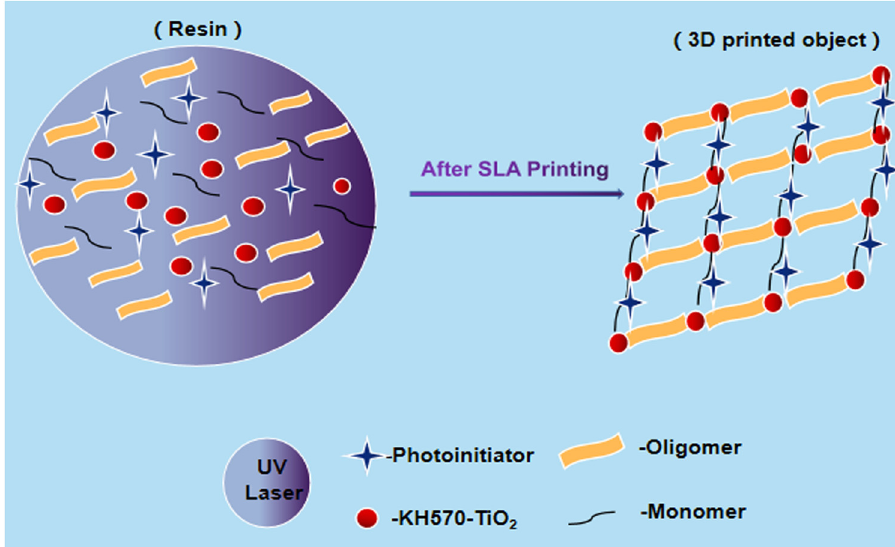
Figure 4: Curing mechanism of nano - TiO 2 - modi fi ed resin.